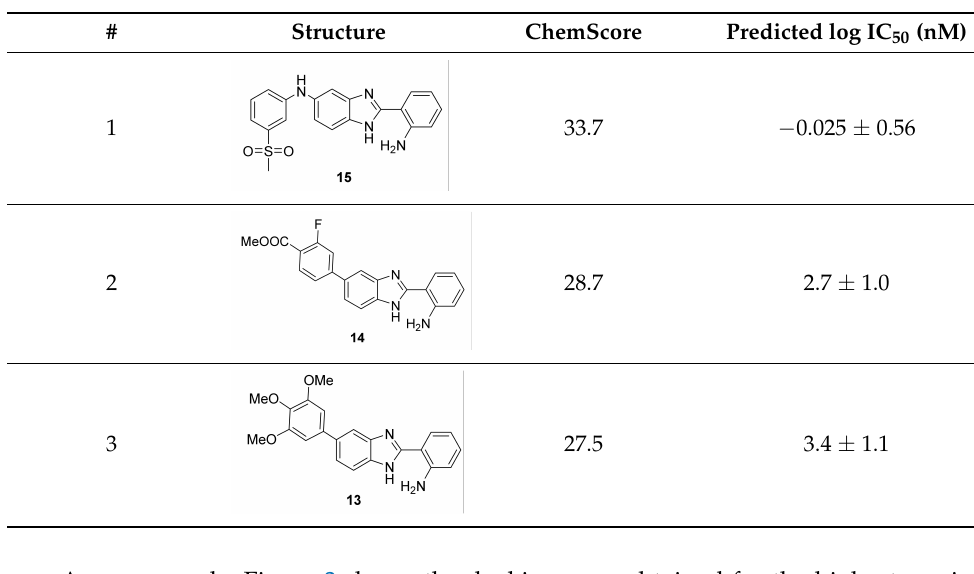
Table 1. Selected 2-(2-aminophenyl)-5(6)-substituted-benzimidazole derivatives with corresponding ChemScore and predicted log IC 50 activity.